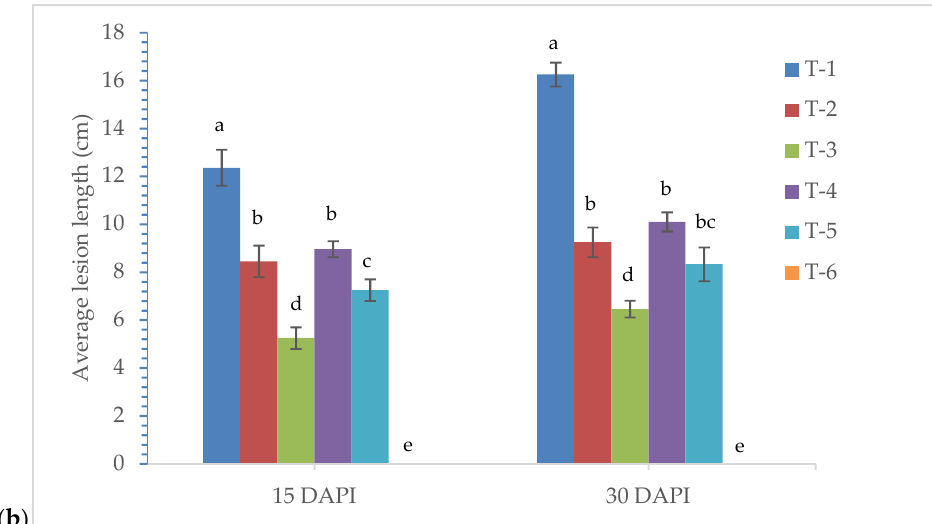
Figure 10. Effects of seed bio-priming on ( a ) disease severity and ( b ) lesion length at 15 and 30 days post inoculation of R. solani under nethouse conditions. Treatments were: T 1 -plants inoculated with R. solani alone; T 2 - R. solani + seed bio-primed with P. aeruginosa MF-30; T 3 - R. solani + seed bio-primed with P. aeruginosa MF-30 + foliar spray of MF-30; T 4 - R. solani + foliar spray of culture filtrate of MF-30; T 5 - R. solani + seed bio-primed with P. aeruginosa MF-30 + foliar spray of culture filtrate of MF-30; T 6 - Control (untreated). Data are mean ± SEM ( n = 5).